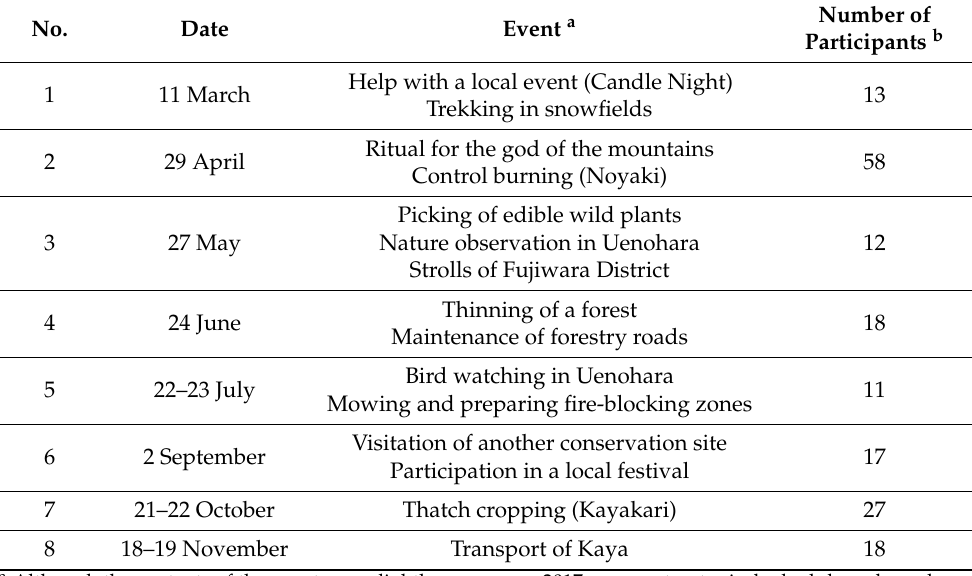
Table 2. Activities of Forest College Seisui in